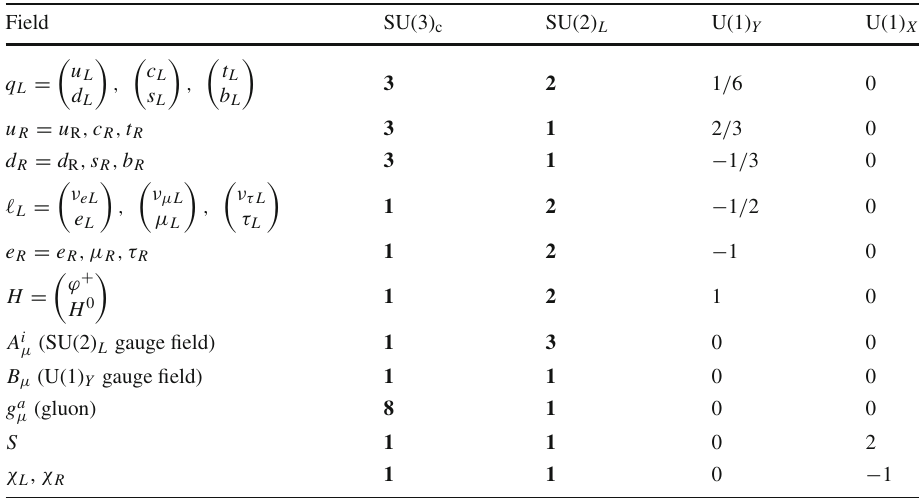
Table 1 Charge assignment for elementary particles